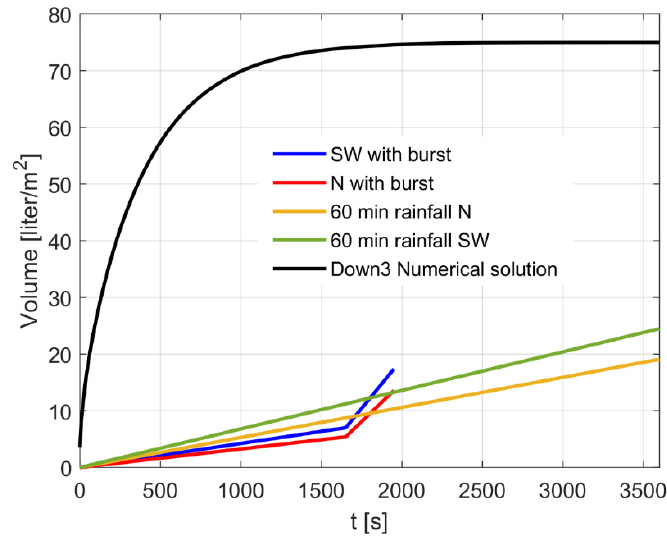
Figure 11. Comparison between the Down-flow SPB storage filling (Down3, numerical solution) [L/m 2 ] and the cumulative rainfall ([L/m 2 ] data from Table 3) as a function of time [s]. The figure also demonstrates the storage capacity of the SPB.